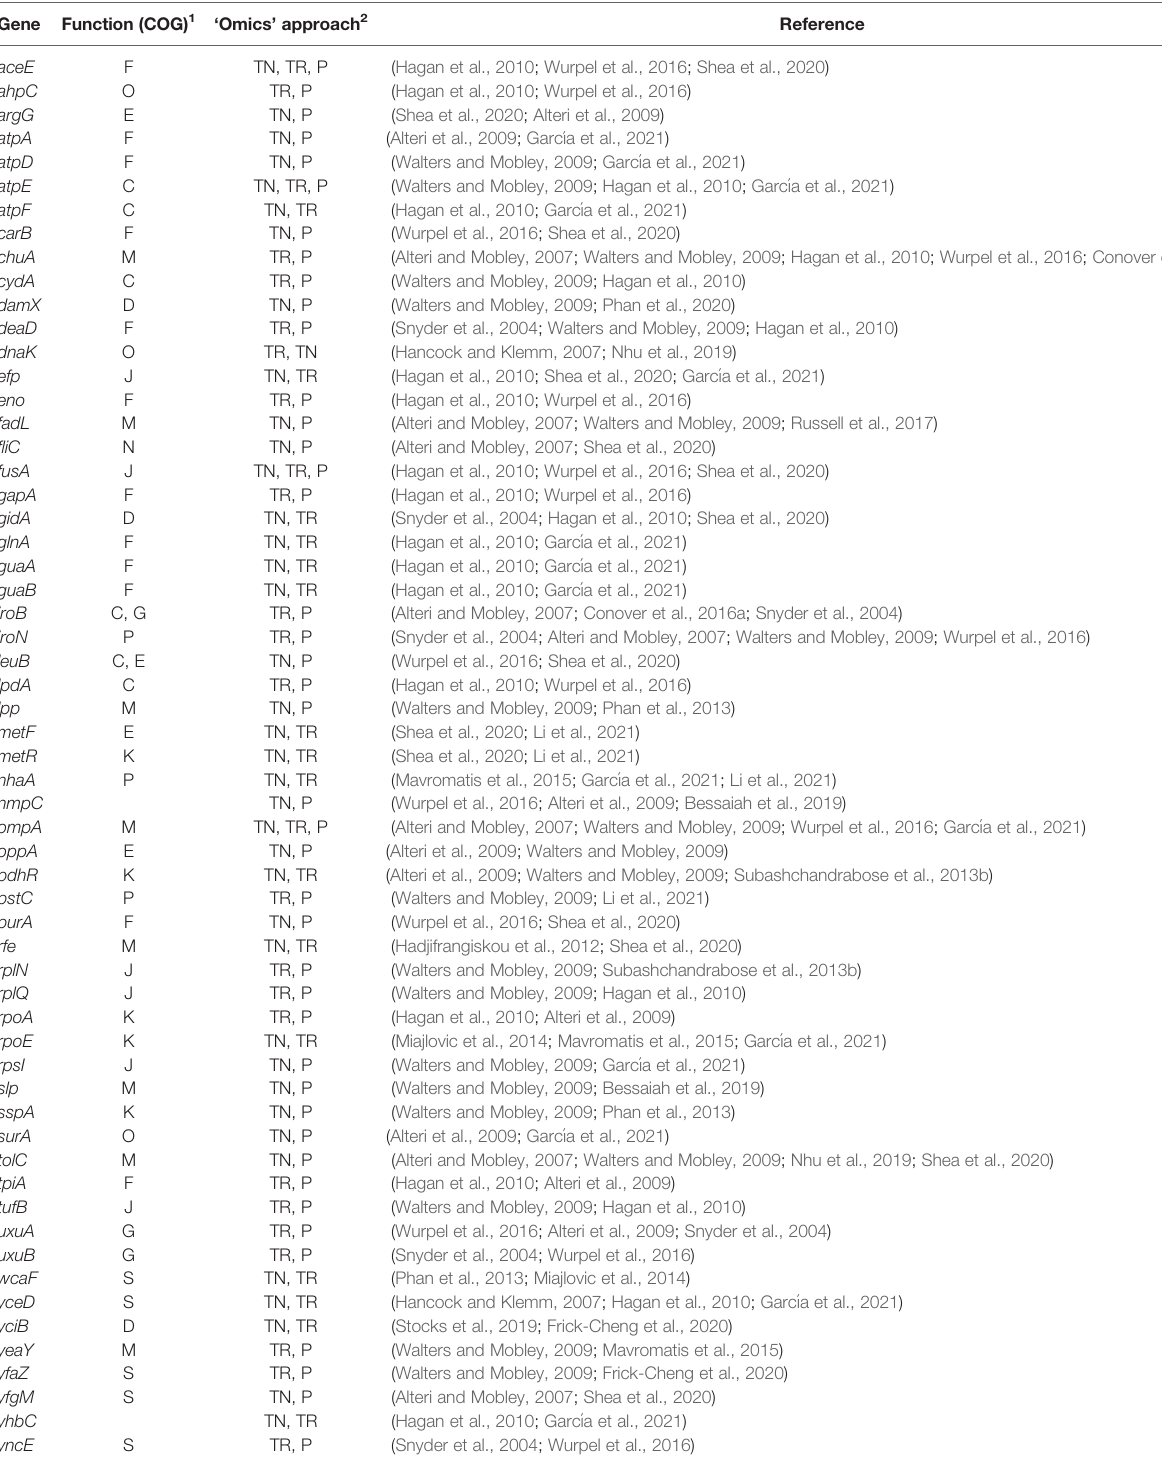
1 COG Code: C, Energy production and conversion; D, Cell cycle control, cell division, chromosome partitioning; E, Amino Acid metabolism and transport; F, Nucleotide metabolism and transport; G, Carbohydrate metabolism and transport; J, Translation, ribosomal structure and biogenesis; K, Transcription; M, Cell wall/membrane/envelop biogenesis; N, Cell motility; O, Post-translational modi fi cation, protein turnover, chaperone functions; P, Inorganic ion transport and metabolism; S, Function unknown. 2 P, proteomics; TN, TraDIS; TR,